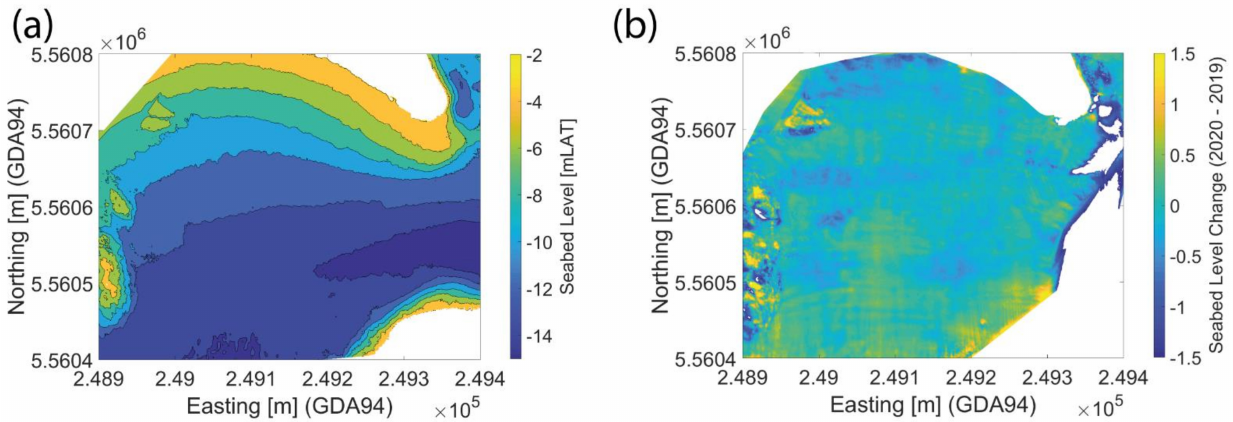
Figure 13. Bedrock spot heights around the pontoon perimeter at Location 2 on 11 March 2021. Spot heights were taken from either the top of the pontoon or top of the aft deck (landward side).